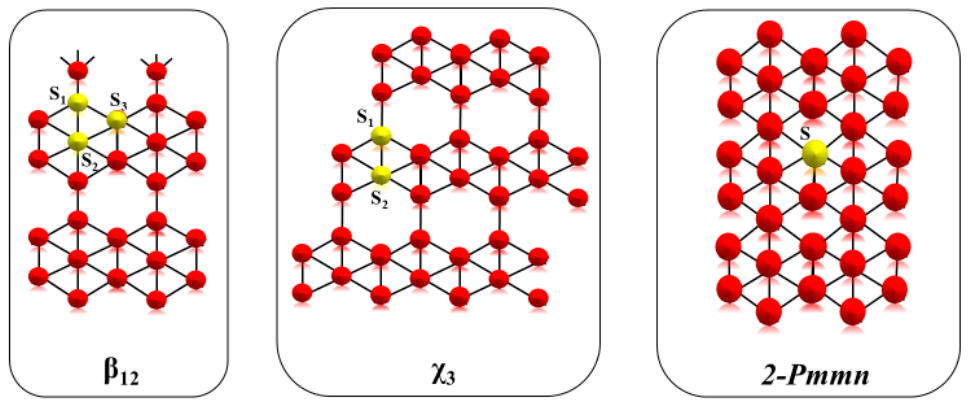
Figure 2. Crystal structures of β 12 , χ 3 and 2 - Pmmn.